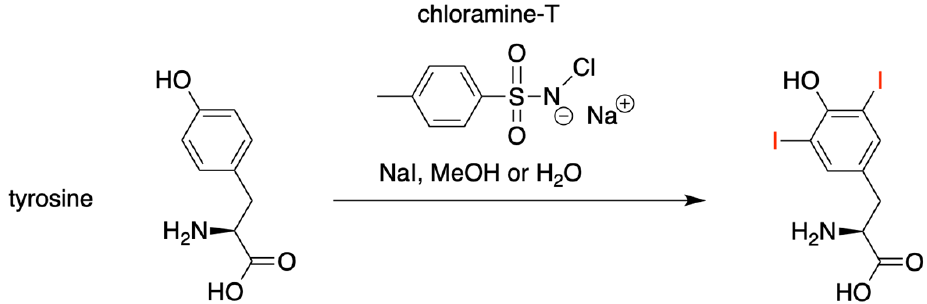
Figure 4. Proposed strategy for immobilizing HBT upon enzymatic cleavage. To exploit the aggregation phenomenon in a molecular brachytherapy strategy, the HBT substrate needs to be radiolabeled. Radiolabeling generally is done at the last step of the synthesis to limit challenges in purification and handling. Moreover, the radiolabeling must be achieved without altering the soluble-insoluble conversion process, both in terms of enzymatic specificity and solubility features. Here, we explored several HBT derivatives and their amenability toward radiolabeling. A new route to introduce radioactive iodine relies on the copper-mediated conversion of a boronic ester [36]; however, we were unable to prepare the required boronate of the HBT derivative. A more traditional chemistry employs N -chloro- p -toluenesulfonamide (chloramine-T) for iodination of substrates such as the phenol of tyrosine, which has been widely used in labeling proteins (Scheme 1) [37–39]. Here, we focused on the installation of natural abundance iodine as a mock (cold) version of 131 I.